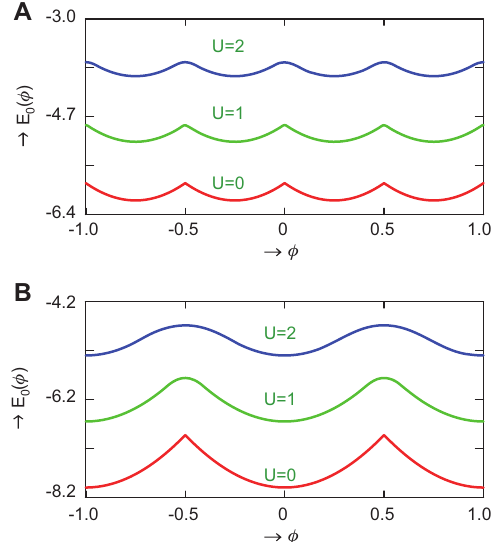
Figure 3 Ground state energy levels as a function of fl ux φ for some typical mesoscopic rings in half-fi lled case, where eigenener- gies are determined through exact diagonalization of the full many- body Hamiltonian. The red, green, and blue curves correspond to U = 0, 1, and 2, respectively. (A) N = 5 and (B) N = 6.